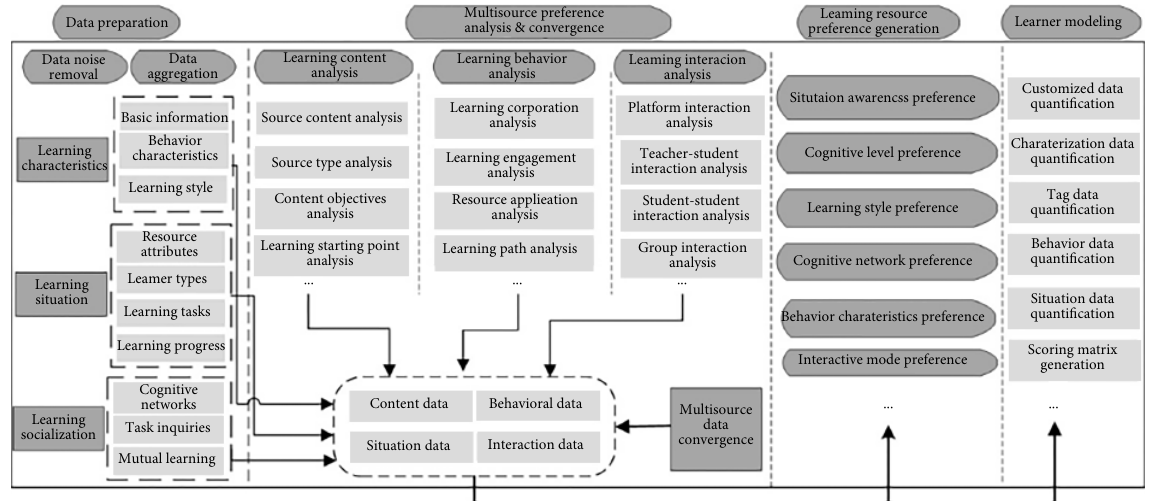
Fig. 2 Learner modeling process that incorporates preference data from multiple